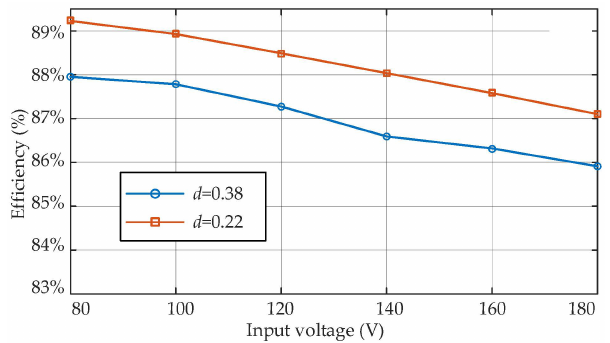
Figure 17. Measured efficiency curves at different input voltages.